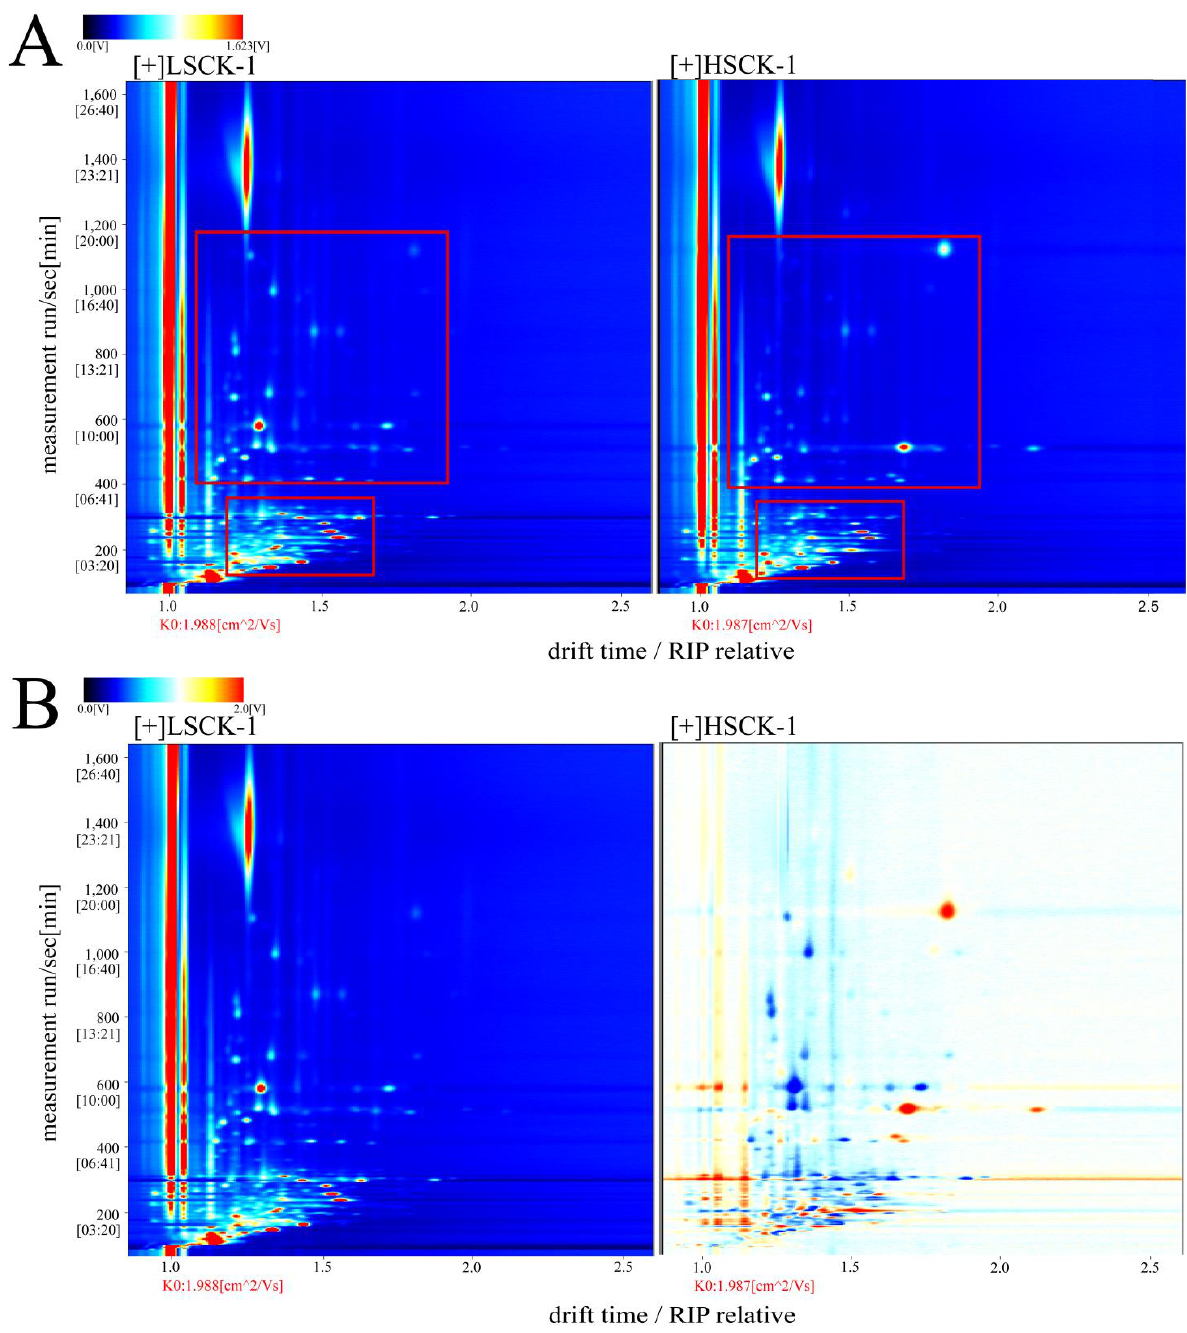
Figure 1. GC-IMS plots of volatile flavor substances of LSCK and HSCK in 3D ( A ) and 2D ( B ).